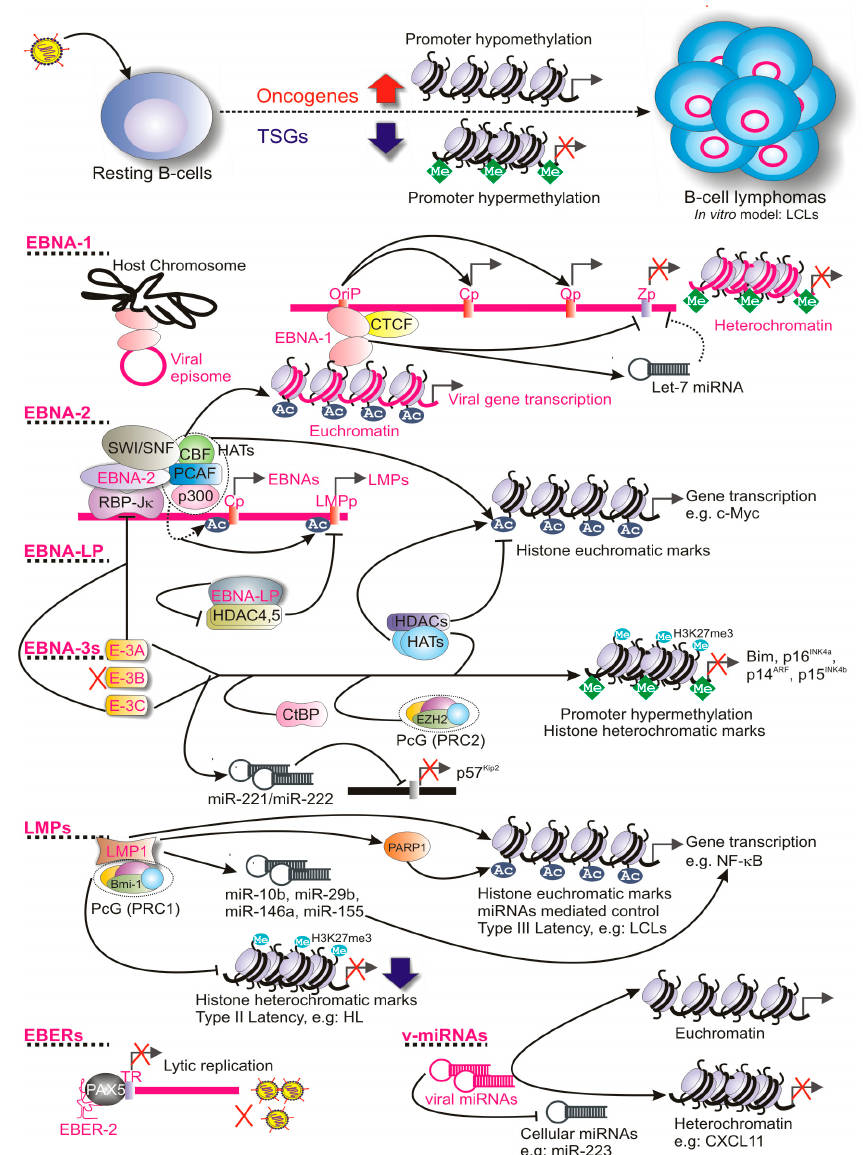
Figure 1. Epstein-Barr virus (EBV) latent transcripts mediated epigenetic regulation during B-cell lymphomagenesis. EBV infection in resting B-cells (RBLs) led to a general up-regulation of oncogenes and down-regulation of tumor suppressor genes (TSGs). EBV nuclear antigens , including EBNA-1, -2, -3A, -3C, -LP, and Latent membrane protein 1 (LMP-1) extensively modulate both viral and cellular gene transcription through epigenetic regulation, leading to B-cell transformation and subsequent B-cell lymphoma development. EBV non-coding RNA, EBER-2, through interaction with B-cell transcription factor PAX5, bind at the viral terminal repeat (TR) region and thereby blocks lytic cycle activation. EBV encoded several microRNAs (miRNAs) that are also involved in gene transcription and thereby contributing to the B-cell lymphomagenesis. Viral DNA and genes/proteins are indicated as pink and cellular DNA and genes/proteins are indicated as black. LCLs: Lymphoblastoid Cell lines; OriP: Origin of replication P; CXCL11: C-X-C motif chemokine ligand